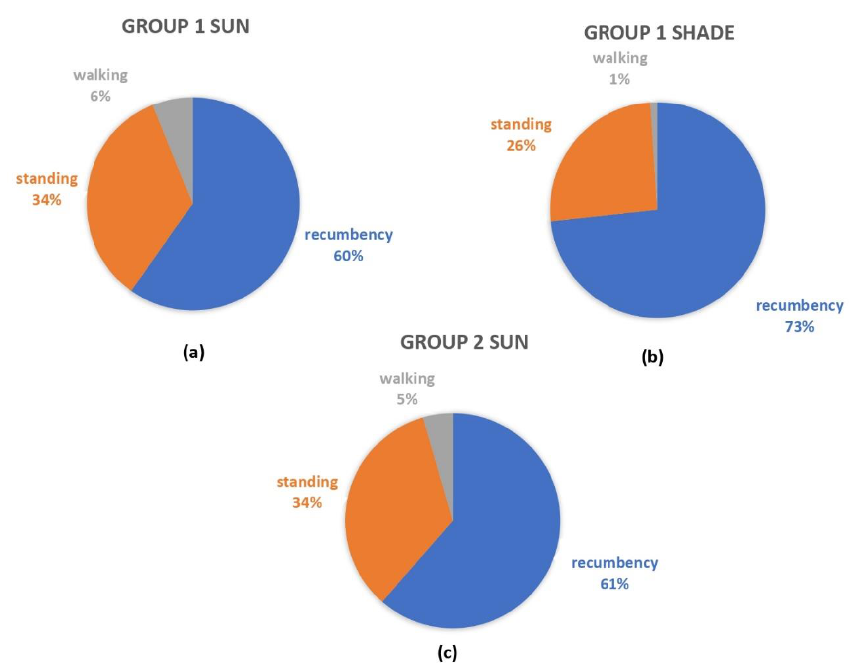
Figure 1. Relative proportions of the mutually exclusive locomotory behaviors shown by dromedary camels kept in different type and locations of pens at the camel market in Doha: ( a ) in the sun of the pens with shelter (Group 1 sun); ( b ) in shaded areas of the pens with shelter (Group 1 shade); ( c ) in the sun of pens without shelter (Group 2 sun).